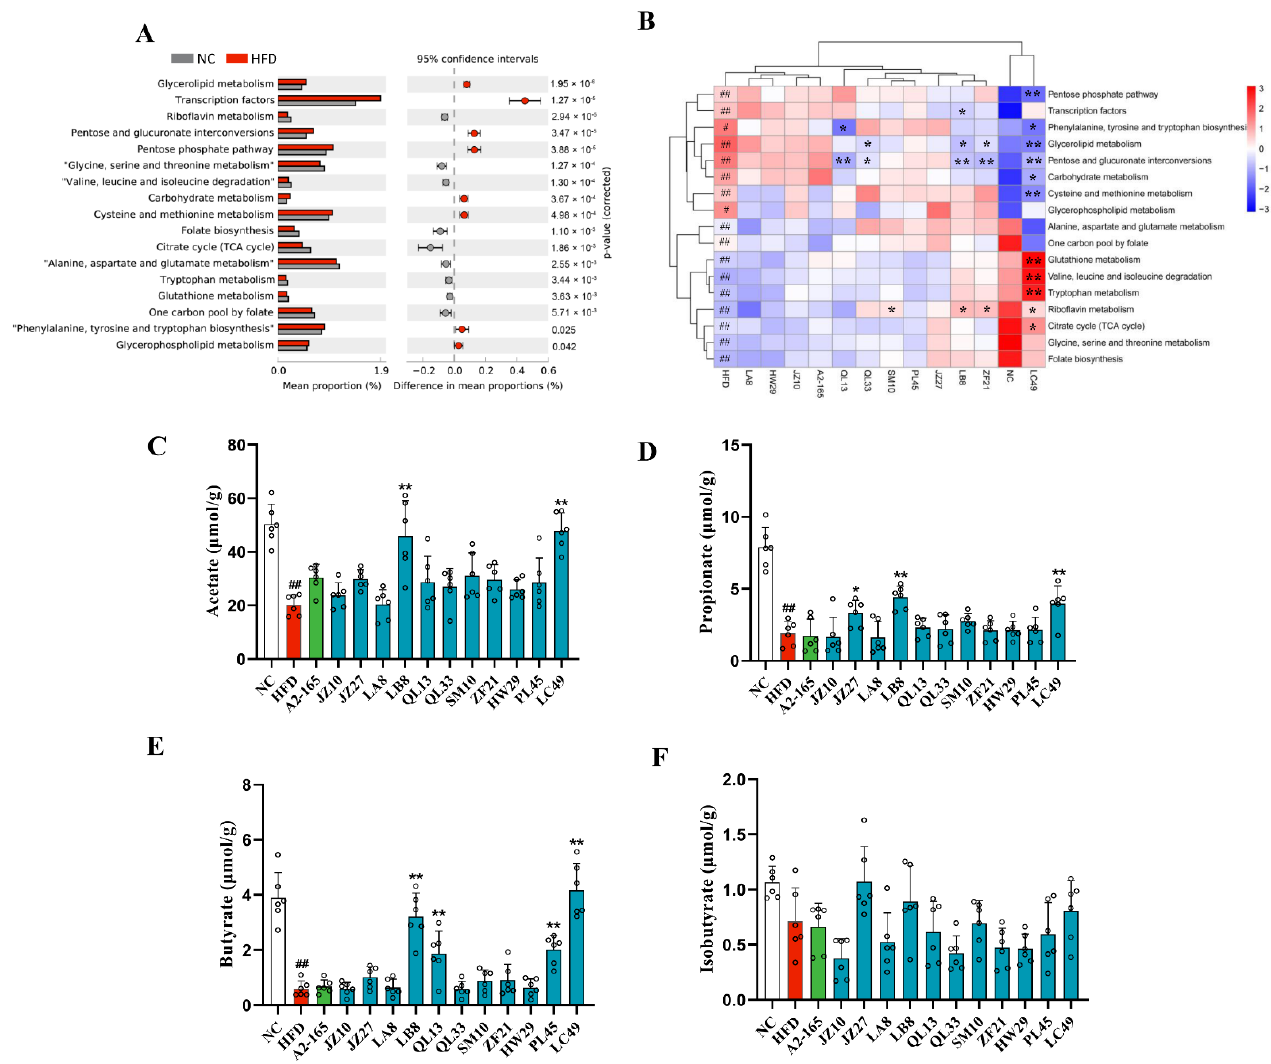
Figure 5. Prediction of microbial functional pathways and short-chain fatty acid production. ( A ) Differential pathways between the NC and HFD groups (two-sided Welch’s t -test at p < 0.05); ( B ) Heatmap of the differential pathways in ( A ) among all groups; ( C – F ) Colonic acetate, propionate, butyrate, and iso-butyrate concentrations. Data are shown as means ± SD; # p < 0.05, ## p < 0.01 vs. NC group, unpaired Student’s t -test; * p < 0.05, ** p < 0.01 vs. HFD group, one-way ANOVA followed by Dunnett’s